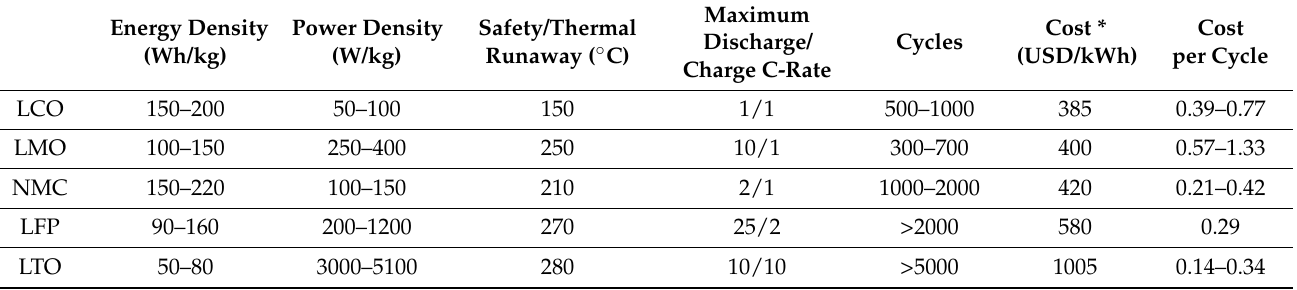
Table 3. Comparison of lithium-ion battery technologies, adapted from